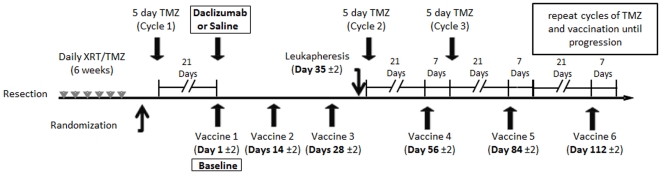
Schema of ZAP IT Trial.